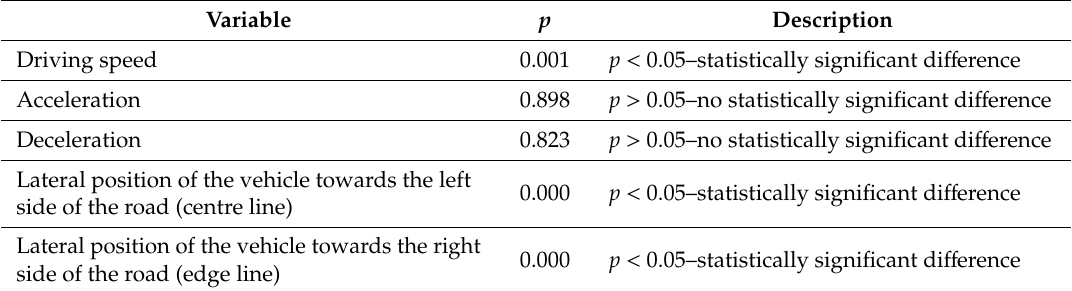
Table 2. T-test results for variables obtained from the driving simulator.